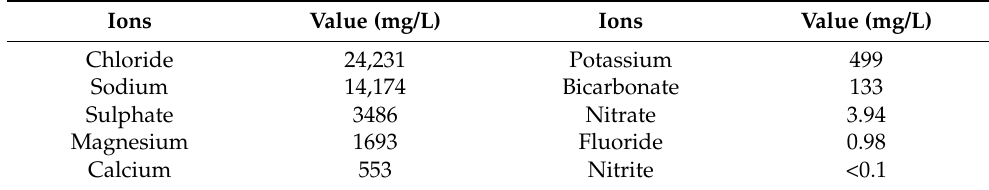
Table 1. Chemical composition of waste brine from an RO at pH 758 plant in Atacama Desert, Chile. Ions Value (mg/L) Ions Value (mg/L) Chloride 24,231 Potassium 499 Sodium 14,174 Bicarbonate 133 Sulphate 3486 Nitrate 3.94 Magnesium 1693 Fluoride 0.98 Calcium 553 Nitrite